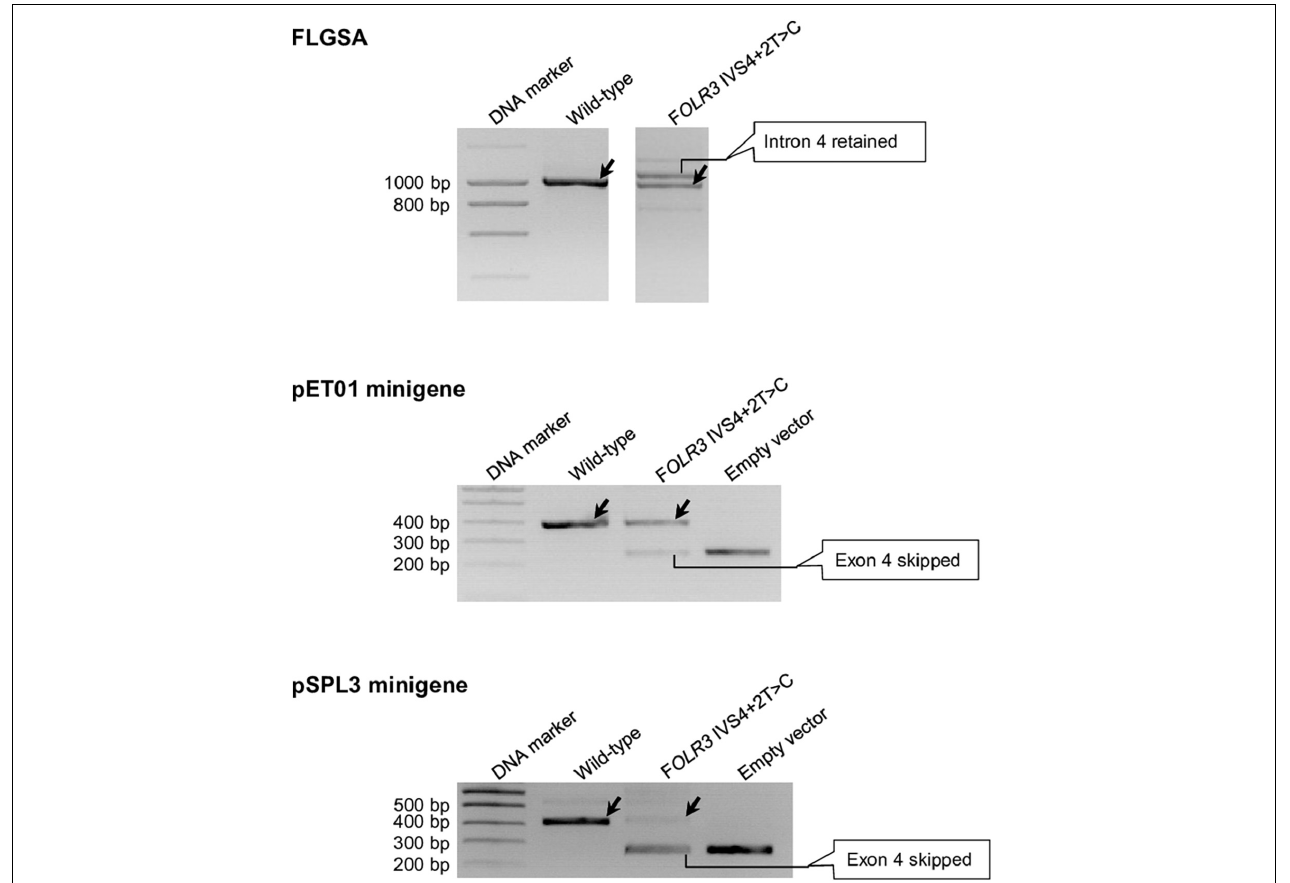
FIGURE 6 | Reverse transcription-polymerase chain reaction results from the pET01 and pSPL3 minigene assays with respect to the FOLR3 IVS4+2T > C variant. Results from the previously performed full-length gene splicing assay (FLGSA) (Lin et al., 2019) are included for the sake of comparison (NB. the aberrant transcript with retained intron 4 was newly sequenced in this study). In all panels, wild-type transcripts are indicated by oblique downward pointing arrows. See Supplementary Figure 6 for the full gel photographs with respect to the minigene assays. The FLGSA data were adapted from Lin et al. (2019) with permission (Copyright 2020 Wiley Periodicals